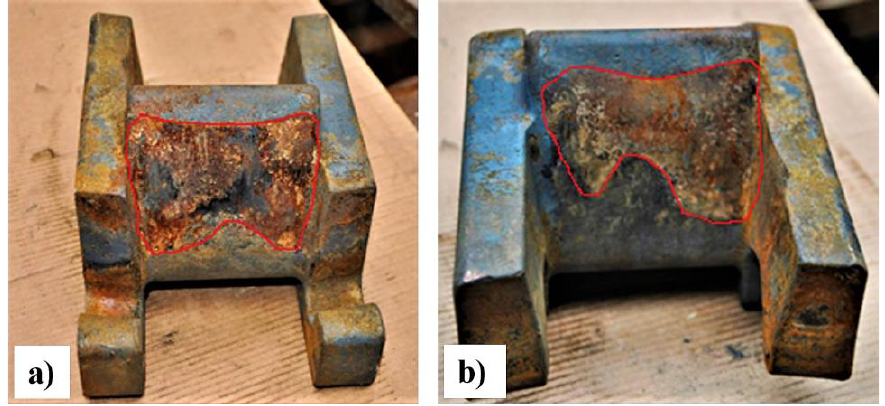
Figure 13. View of the wear of the tooth surface of the toothed segment, (marked with red frames). installed in the section: ( a ) rectilinear, ( b ) with disturbances of rectilinearity.